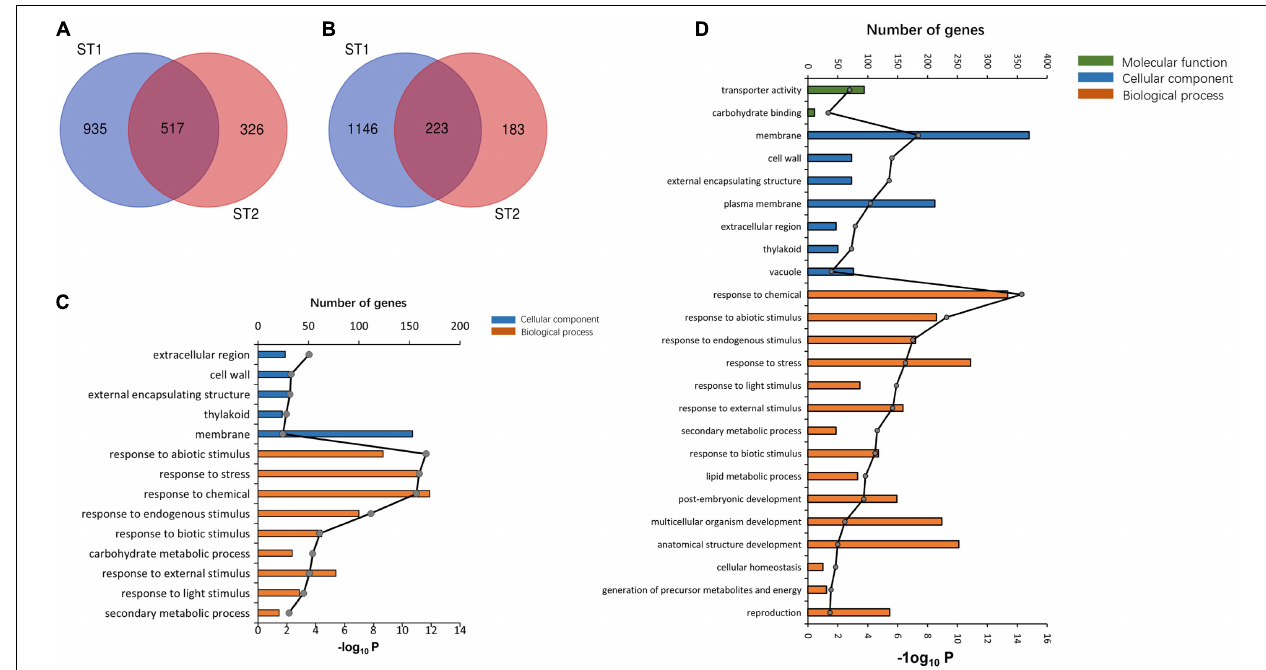
FIGURE 6 | The transcriptome analysis of salt stress between 93 and 11 and PA64s. Venn diagrams showing the common (A) upregulated and (B) downregulated DEGs among ST1 (93-11 ST 0 vs. 93-11 ST 100 ) and ST2 (PA64s ST 0 vs. PA64s ST 100 ). GO classification at (C) ST1 and (D) ST2.